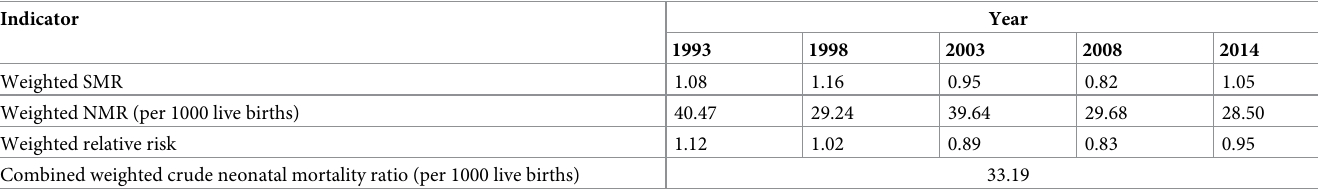
Table 3. Distribution of selected indicators in Ghana